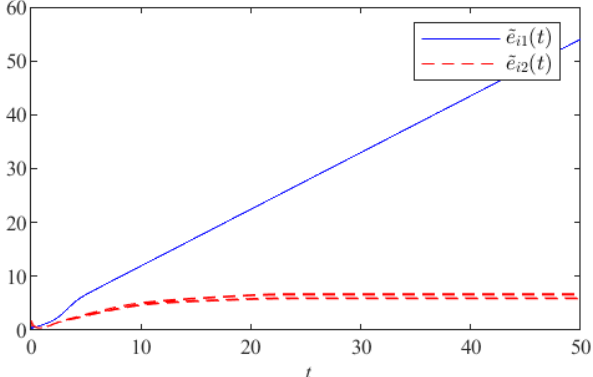
Figure 7. ˜ e i ( t ) with the control gains d = 1.9 and k = 0 in Example